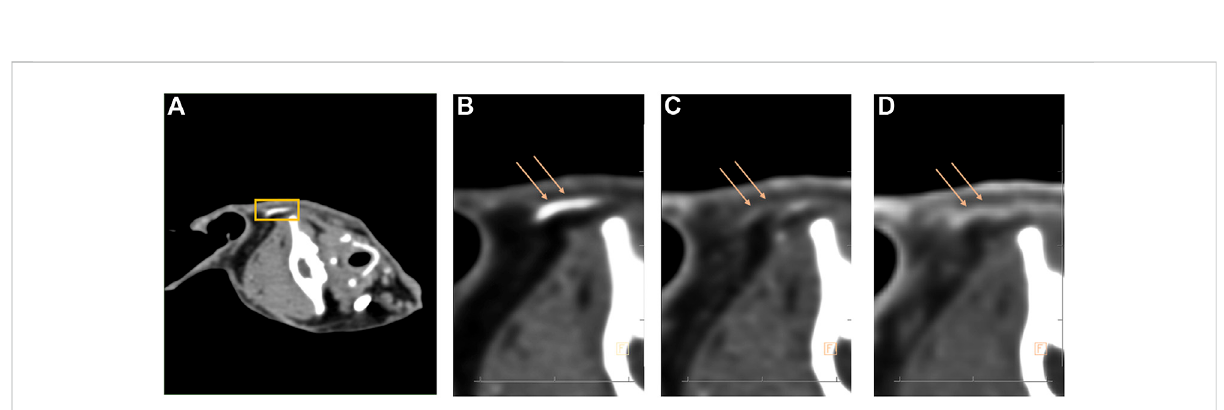
FIGURE 2 Computed tomography scans the sagittal plane of the entire skull and the marginal ear artery was marked with a yellow square (Figure 2A). The auriculararteryis fi lledwithbloodvessels(Figure2B),andthebloodvesselsaresigni fi cantlyconstrictedafteradministrationofephedrine(Figure2C). The diameter of the marginal auricular artery partially recovered within 30 min (Figure 2D). The loss of visibility of blood vessels due to narrowing of blood vessels and insuf fi cient fi lling of contrast agent (Figure 2C).